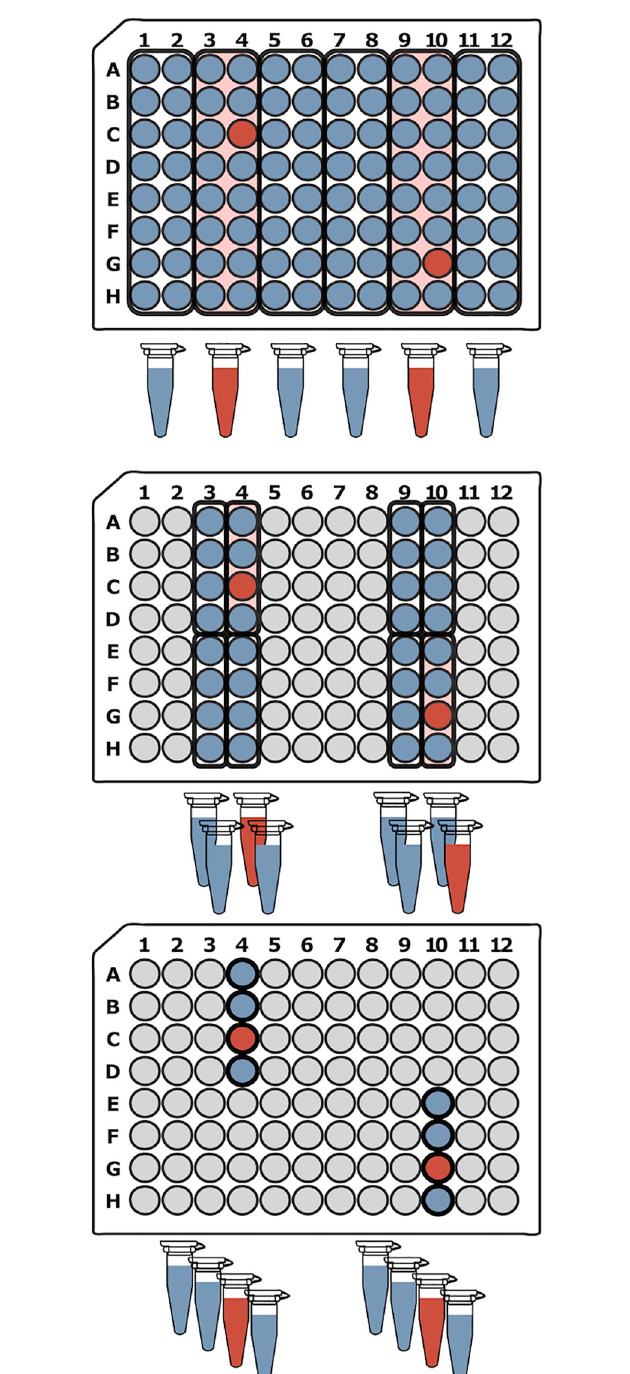
Fig 5. Modified 3-Stage pooling example. For 96 samples and an estimate of 2 positive samples, the Modified 3-Stage approach begins by creating 6 pools with 16 samples each. The positive pools from the first step are then subdivided into 4 groups of 4 in the second step. In the final step, the samples from the positive pools in step 2 are tested individually. In the modified 3-Stage approach, the pools are recursively subdivided into groups instead of arbitrarily redividing the remaining samples at each step. This is simpler and keeps the samples for each subsequent pool in close proximity. The total number of tests depends on the arrangement of the positive samples, but in this example, the modified 3-stage algorithm requires 22